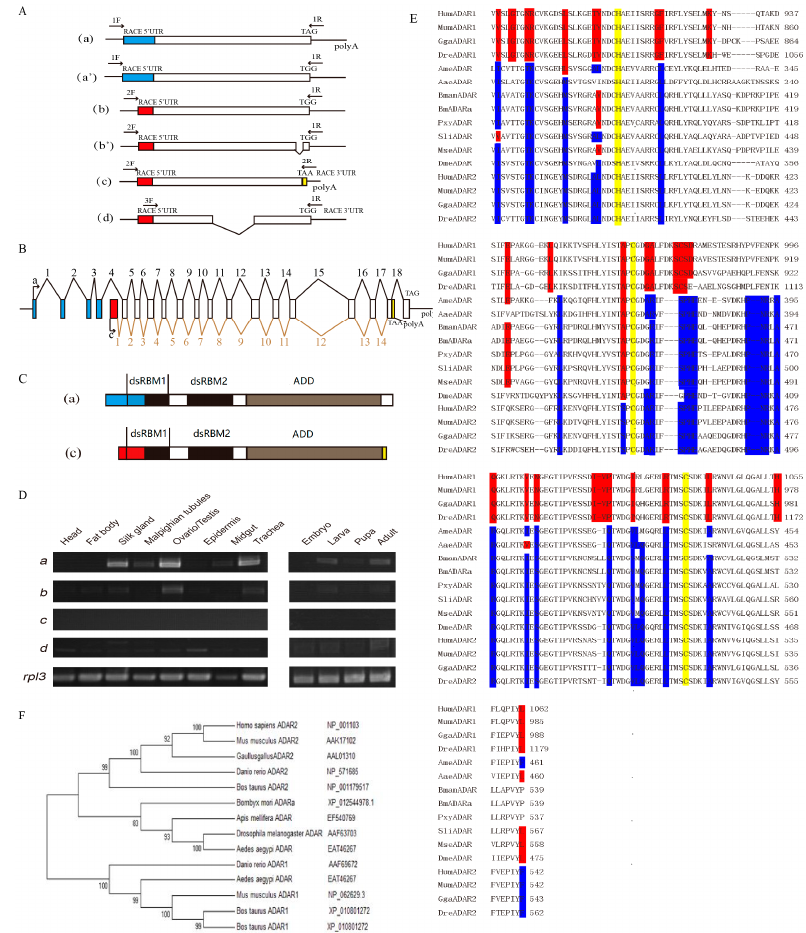
Figure 1. Molecular cloning and spatio-temporal expression of BmADAR transcripts and amino acid sequences analysis. ( A ) Di ff erent transcripts amplified from cDNA. Arrows indicate the location and direction of the primers. Straight lines are untranslated regions, white bars are coding sequences acquired by RT-PCR, while colored bars are coding sequences obtained by 5 (cid:48) -RACE and 3 (cid:48) -RACE. ( B ) Alternative splicing patterns and gene structures of transcripts a and c. Numbers indicate the exons. ( C ) Comparison of protein polypeptide structures between BmADARa and BmADARc. ADD, adenosine deaminase domain, dsRBM, double-stranded RNA binding motif. ( D ) Expressional patterns of BmADAR transcripts in di ff erent tissues from day 3 fifth instar larvae (left) and at di ff erent developmental stages (right, larval stage is the fifth instar). Transcription of Bmrpl3 was used as a control. ( E ) Alignment of the adenosine deaminase domains among BmADARa and some known ADAR, ADAR1 and ADAR2 in insects and vertebrates. Red and blue represent the positions that were conserved in vertebrate ADAR1 and ADAR2 , respectively. Yellow indicates the chelated zinc residues. GenBank accession numbers are as follows: BmADARa, Bombyx mori ADARa, QJD20810; HumADAR1, Homo